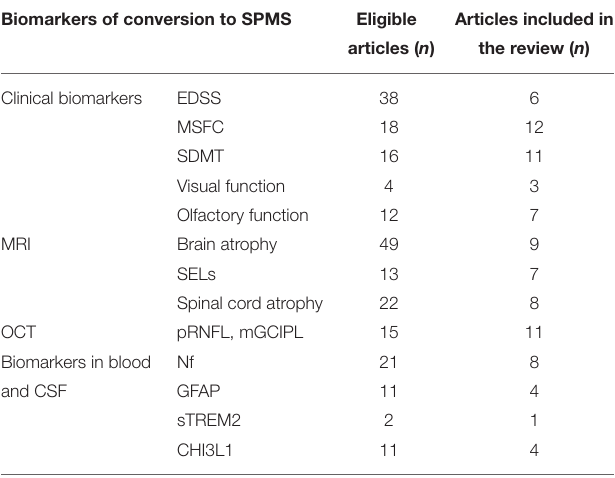
TABLE 1 | Number of articles after applying selection criteria for each biomarker of conversion to secondary progressive multiple sclerosis (SPMS). Biomarkers of conversion to